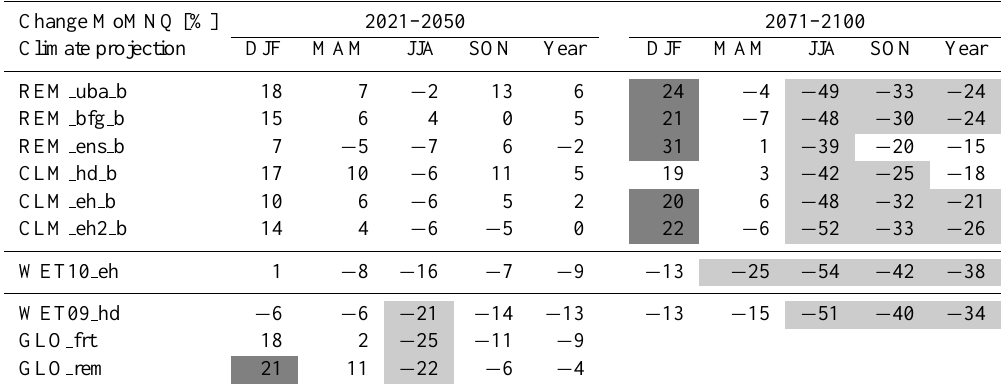
Table 2. Changes [%] in mean monthly low flow (MoMNQ) at gauge Passau-Ingling/Inn, in near and distant future (GLOWA projections not available for distant future), data relative to reference run of the respective climate projections in 1971–2000 for December-January-February